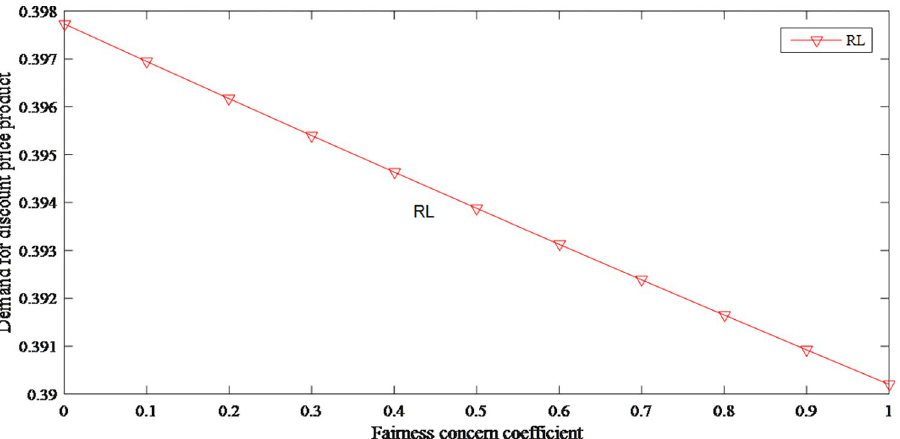
Fig 11. The impact of fairness concerns on demand for discount price